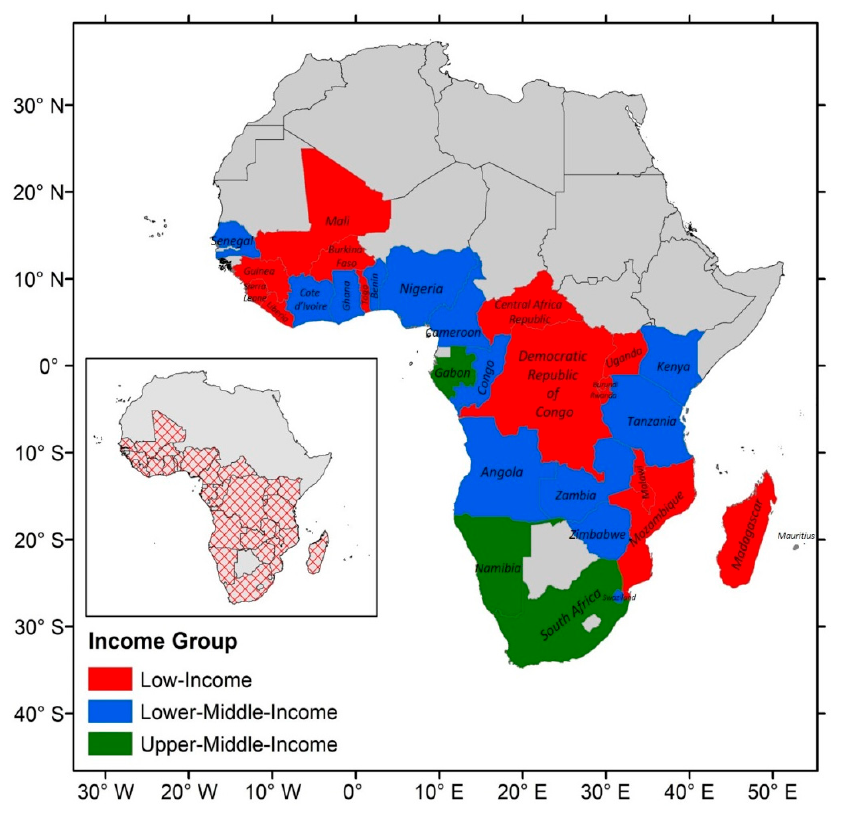
Figure 2. Map of the study area.